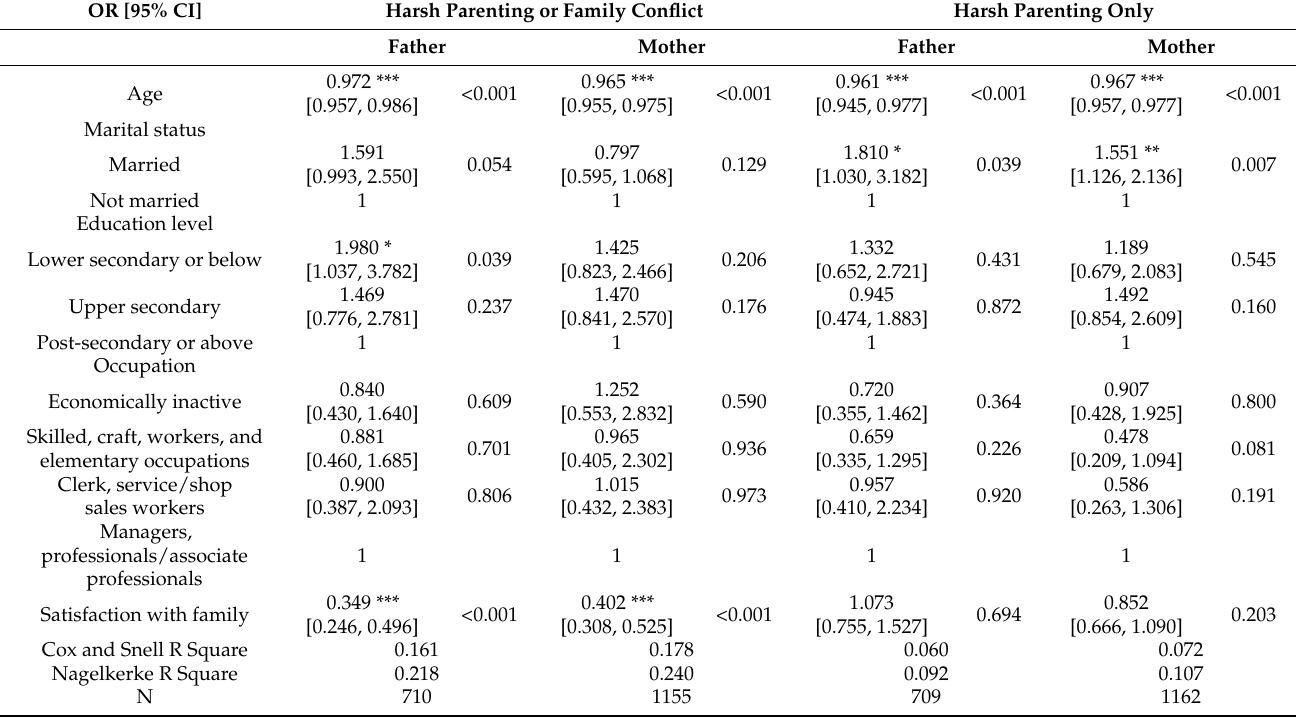
Table 2. The occurrence and co-occurrence of harsh parenting and family